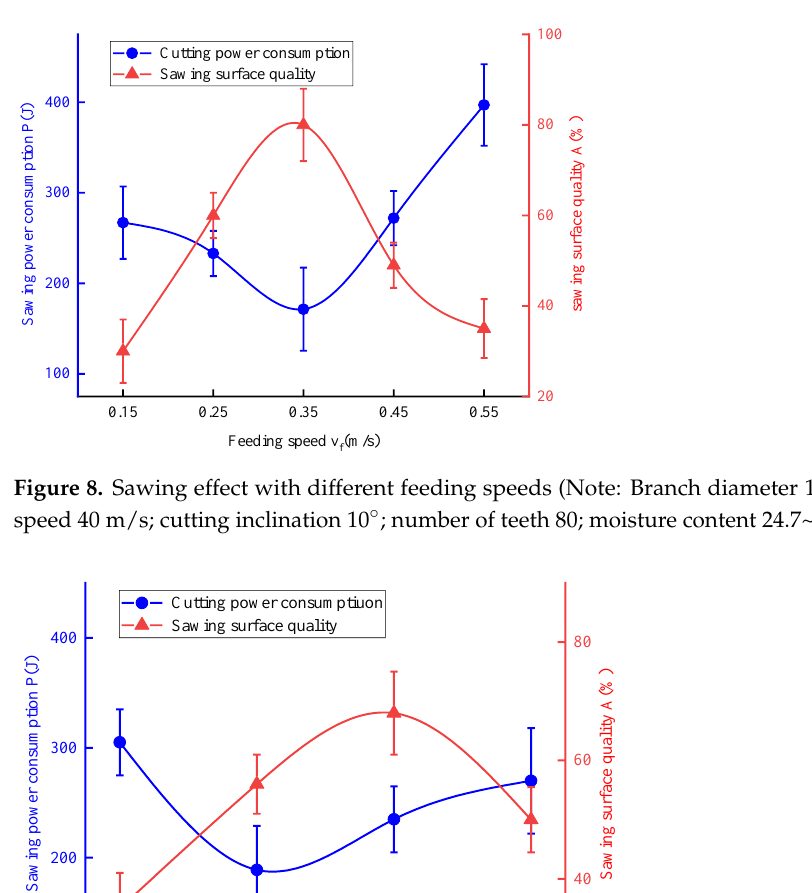
0.35 m/s; cutting inclination 10°; number of teeth 80; moisture content 24.7~28.3% ).